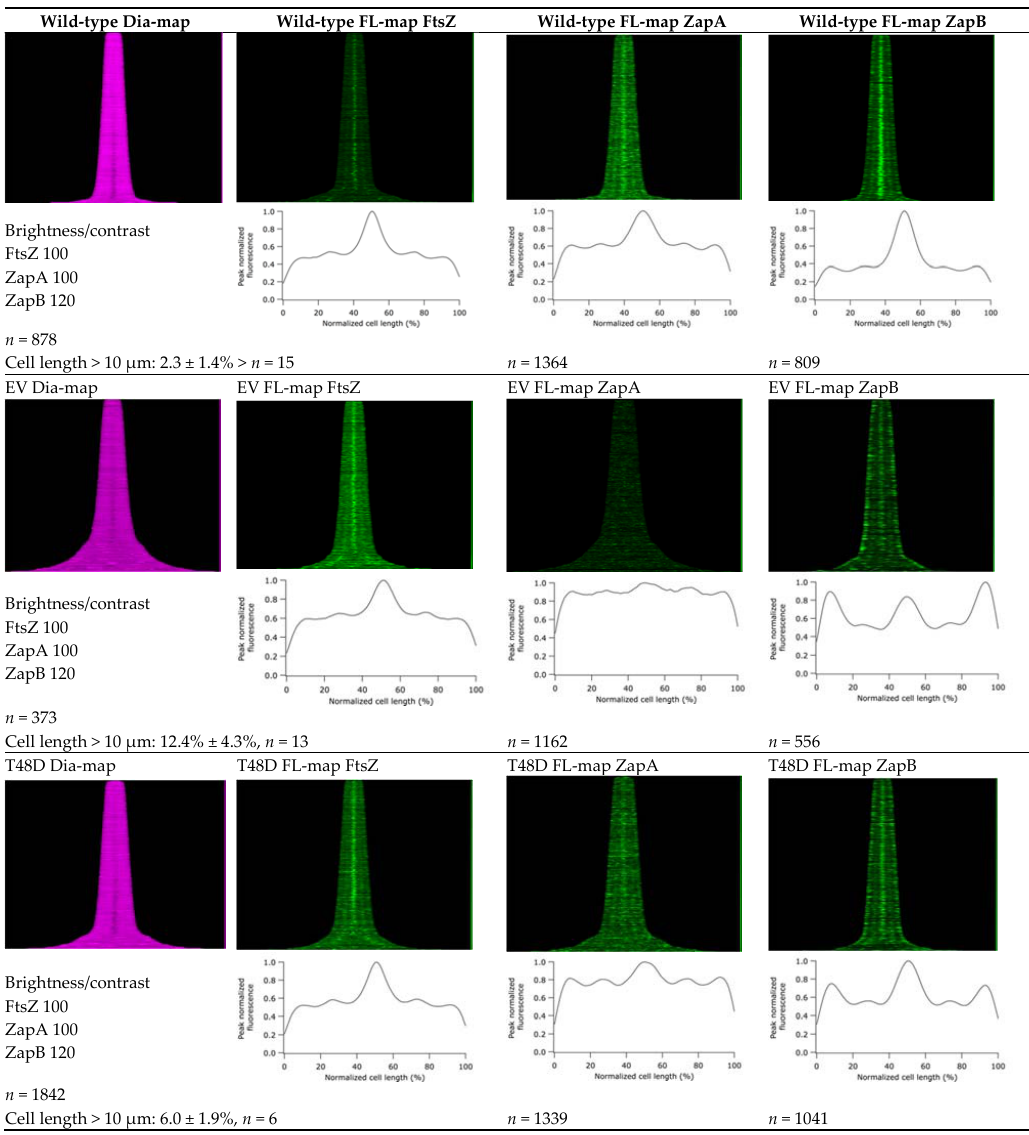
Figure 5. Map of diameter and map of fluorescence profiles and average fluorescence profile of FtsZ, ZapA, and ZapB of TB28 ∆ zapA [10] expressing ZapA mutants from plasmid. The cells were grown exponentially in rich medium at 37 °C and the OD600 was kept below 0.3. Expression of the mutants was induced with 50 µM IPTG for six mass doublings. Cells were fixed and immunolabeled as described in the experimental procedures. Of each sample, from left to right the map of diameter of the FtsZ-labeled sample, the map of fluorescence of the FtsZ-labeled sample, the map of fluorescence of the ZapA-labeled sample, and the map of fluorescence of the ZapB labeled sample is shown. The cells are sorted according to their length in the maps (small cells on top and the longest cell on the bottom of the map). The number of analyzed cells is indicated and the percentage of cells with a cell length of more than 10 µm and the S.E.M. from a number ( n ) of experiments as indicated are shown. Brightness and contrast reflect the grey values within the map of fluorescence. EV is TB28 ∆ zapA containing the plasmid pTHV037 [4] with the same resistance marker but without the ZapA gene. All mutants are shown in the supporting information Figure S4.